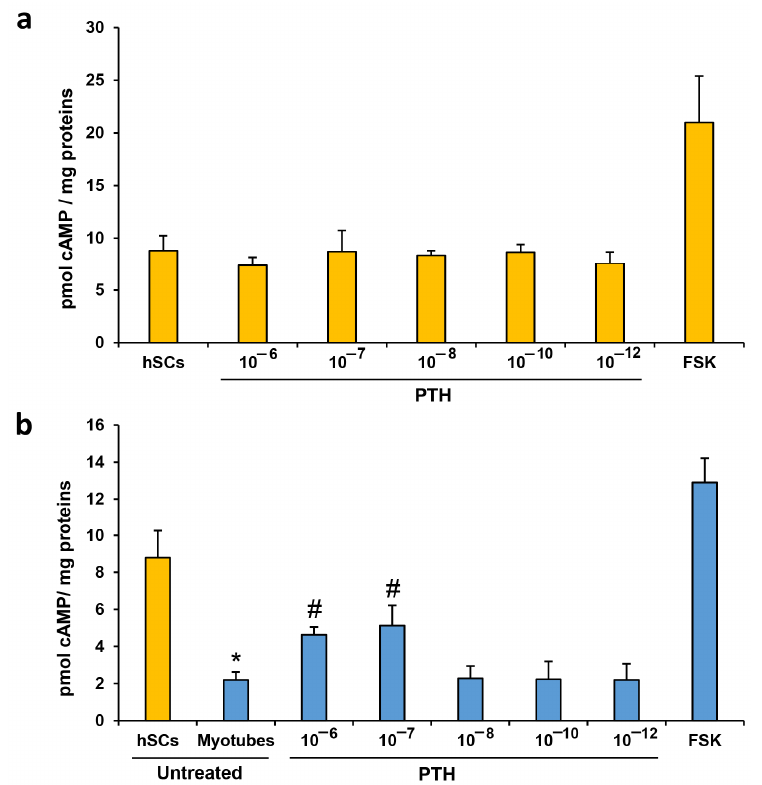
Figure 3. cAMP levels in proliferating hSCs ( a ) and in differentiated myotubes ( b ) treated for 30 min with different concentrations of PTH (1-84), ranging from 10 − 6 to 10 − 12 mol/L and with FSK 10 µmol/L used as positive control. The cAMP values, normalized on total protein content and expressed as pmol/mg of proteins, are the mean ± SD of three cell lines repeated in quadruplicate. ANOVA analysis with Bonferroni’s multiple comparison test. # p ≤ 0.05 vs. untreated myotubes, * p ≤ 0.001 vs. untreated hSCs .